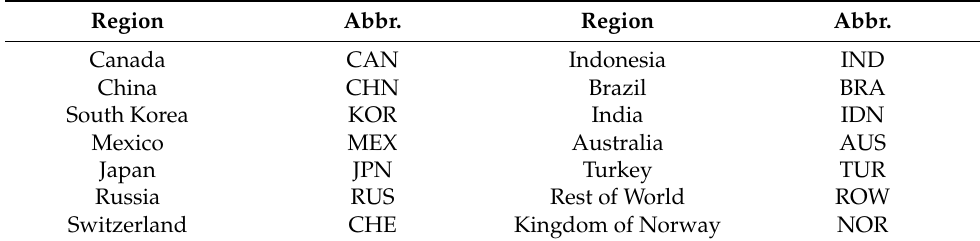
Table A1. Regions in world input-output